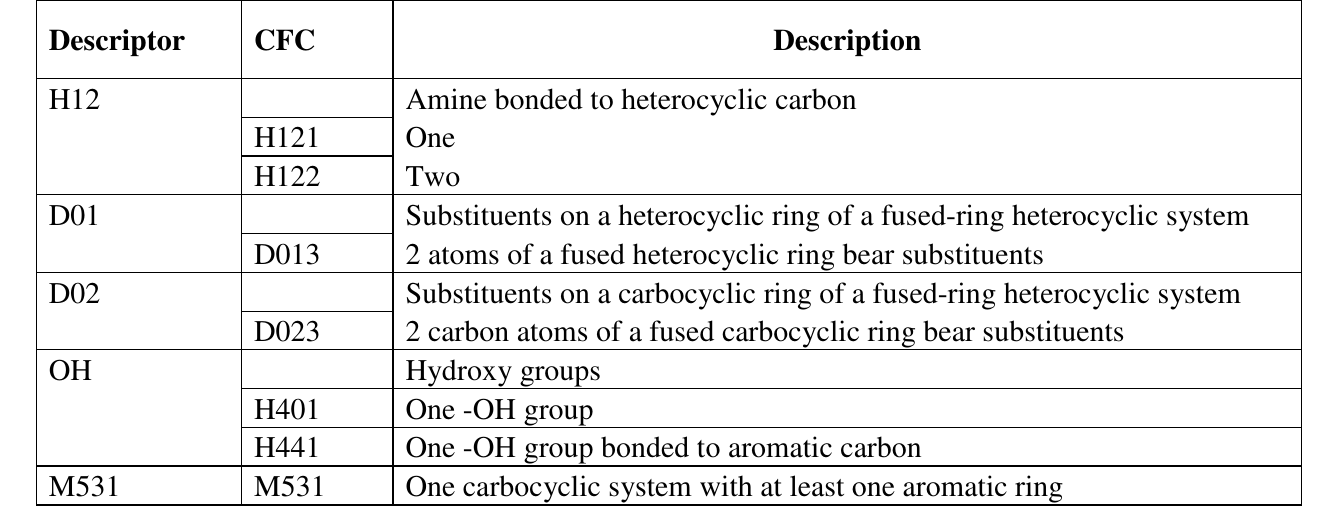
Table 1. Descriptors and chemical fragmentation codes (CFC) involved in CDK